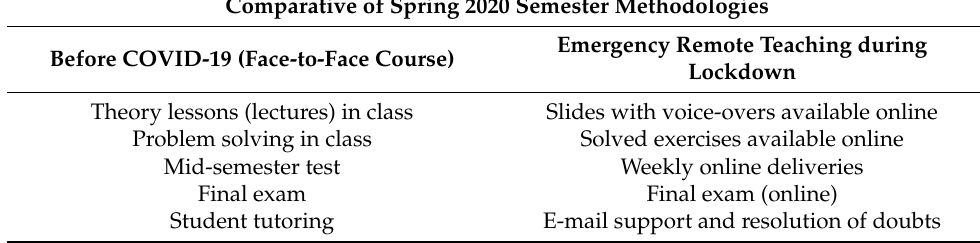
Table 1. Chemistry course face-to-face and remote